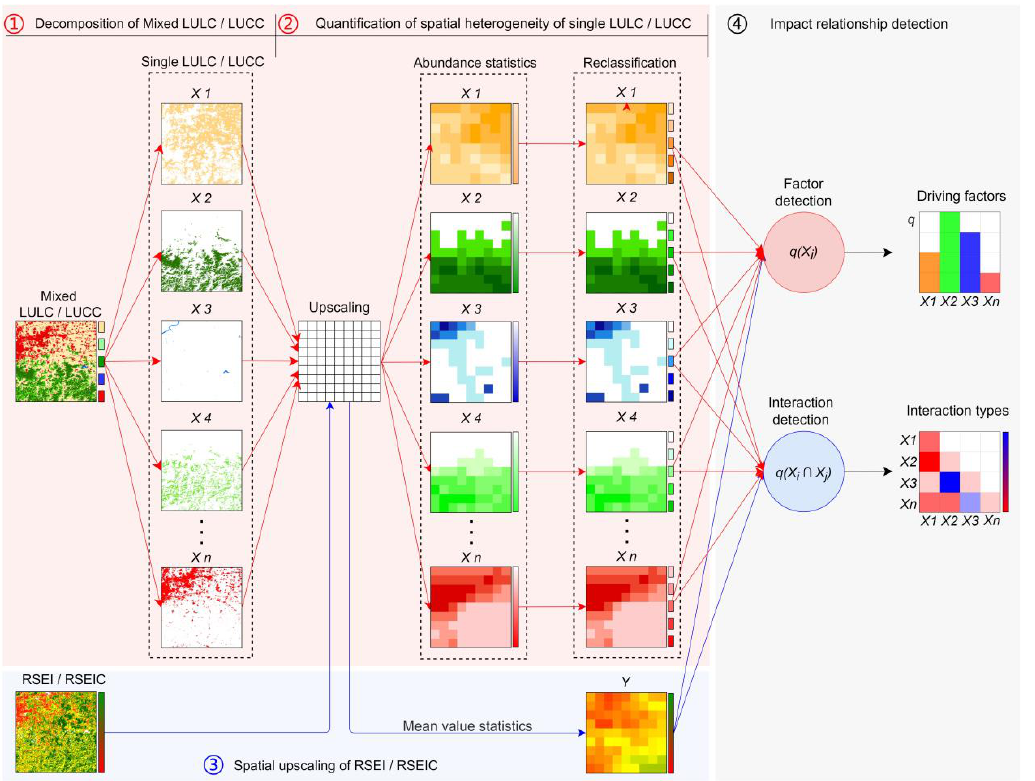
Figure 2. Discretization process of the factors. LULC/LUCC are land use/land cover or land use/land cover change. X1, X2, …, Xn denote impact factors, which are single types decomposed from the mixed LULC/ LUCC and are ultimately typological quantities. RSEI/RSEIC denote variables Y, which are ecological quality or changes in ecological quality and are numerical quantities.